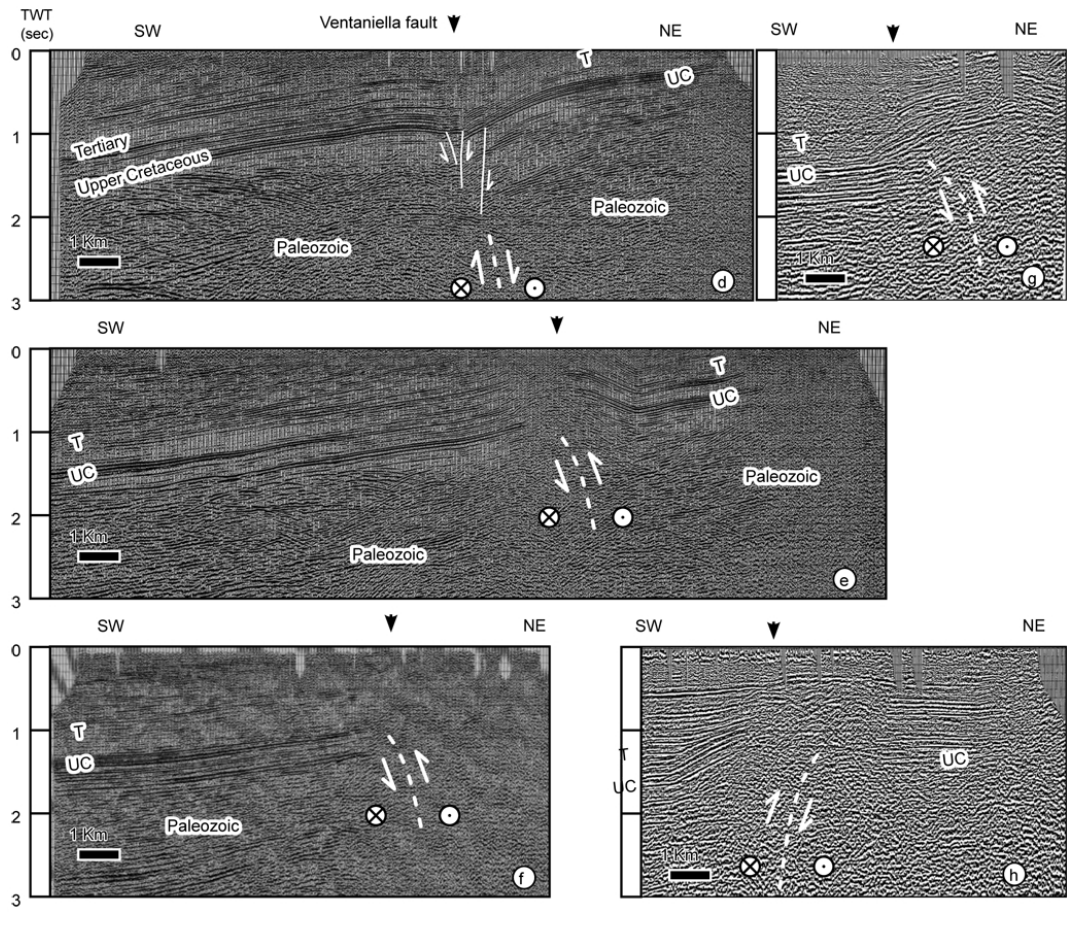
Fig. 10. Seismic lines crossing the Ventaniella Fault in the Duero Basin.